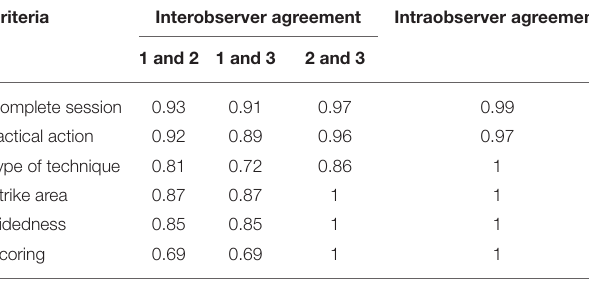
TABLE 3 | Cohen’s kappa indexes for agreement between observers.